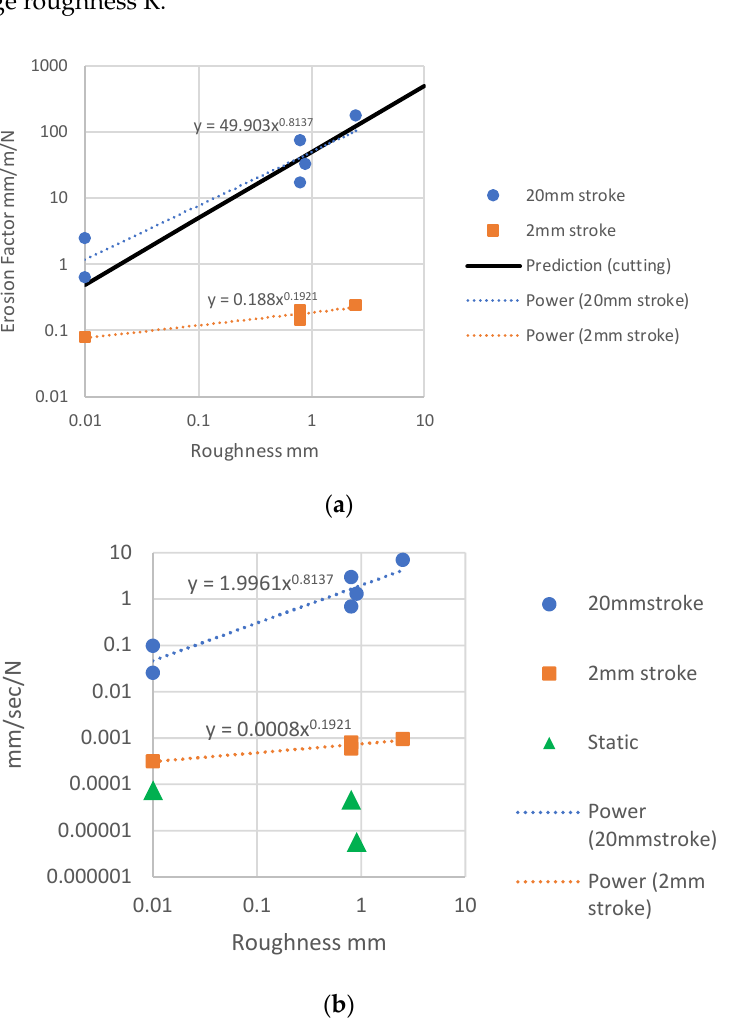
Figure 10. ( a ) Erosion factor as a function of roughness for the two different strokes. Power-law fitting lines through the data, and a prediction line using a simple model of cutting. ( b ) Time-based erosion factor, showing all groups tested.